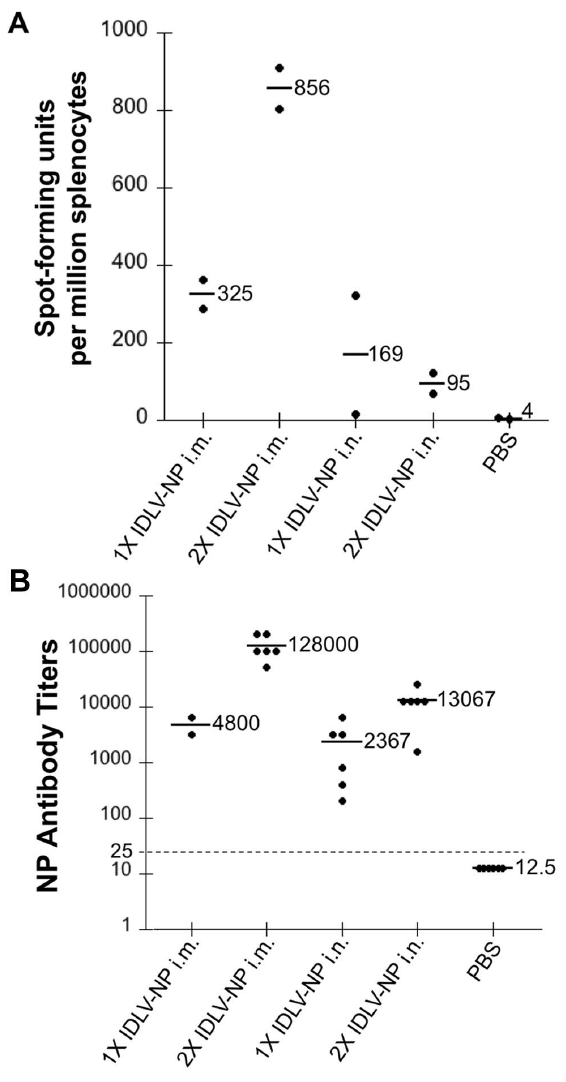
Figure 4. Immunization with IDLV-NP induces NP-specific cell- mediated and humoral immune responses. Separate groups of mice were inoculated either once (1X) or twice (2X), 4 weeks apart, with IDLV-NP via either the i.m. or i.n. route of administration. Mice that were injected i.m. with PBS served as a negative control. ( A ) Splenic T cell responses were evaluated 4 weeks following the final immunization by IFN- c ELISPOT after restimulation with the immunodominant H-2k d - restricted 9-mer NP peptide, or with an unrelated H-2k d -restricted 9-mer peptide (not shown). ( B ) Serum was collected from each mouse prior to the first immunization and 4 weeks after the last immunization. NP- specific IgG in serially-diluted serum samples was measured by indirect ELISA assay and is expressed as endpoint titer. The lower limit of detection is indicated by the dotted line. For all panels, each dot represents one mouse, and bold lines indicate the mean.